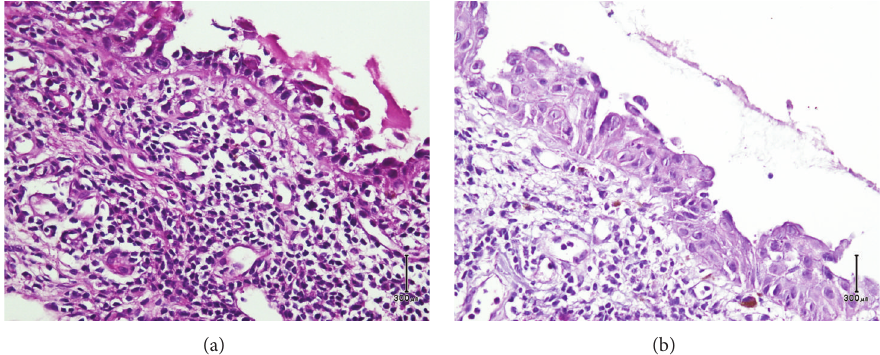
Figure 2: Lip mucosa showing suprabasal acantholysis, clefting, and retraction of tonofilaments.